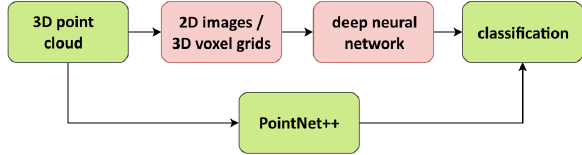
Figure 1. Basic principle of 3D DNNs like PointNet++, operating directly on 3D point clouds without a prior transformation into 2D images or 3D voxel grids